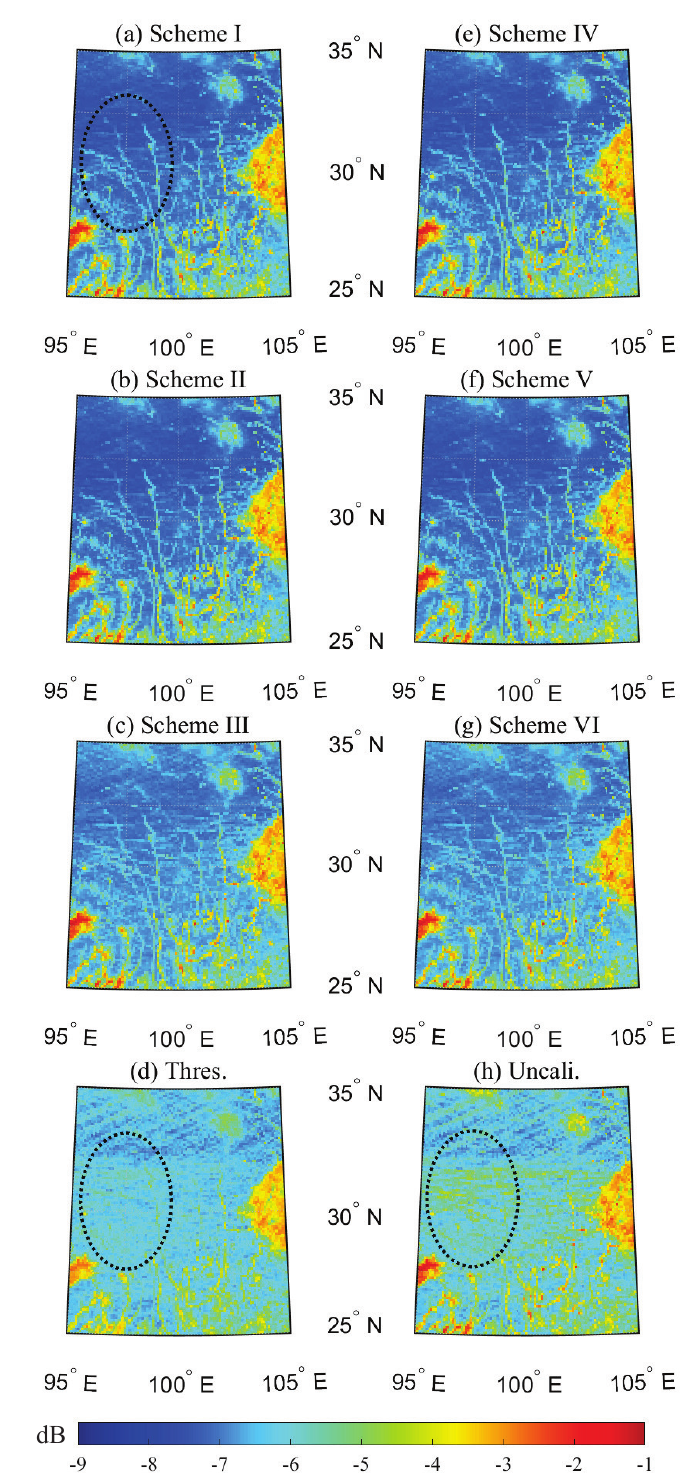
Figure 5. Annual mean of Γ for 2020 with/without calibration: ( a ) Scheme I, ( b ) Scheme II, ( c ) Scheme III, ( d ) Thres., ( e ) Scheme IV, ( f ) Scheme V, ( g ) Scheme VI, and ( h ) Uncali. Inland water can be well identified from the calibrated data (see the black